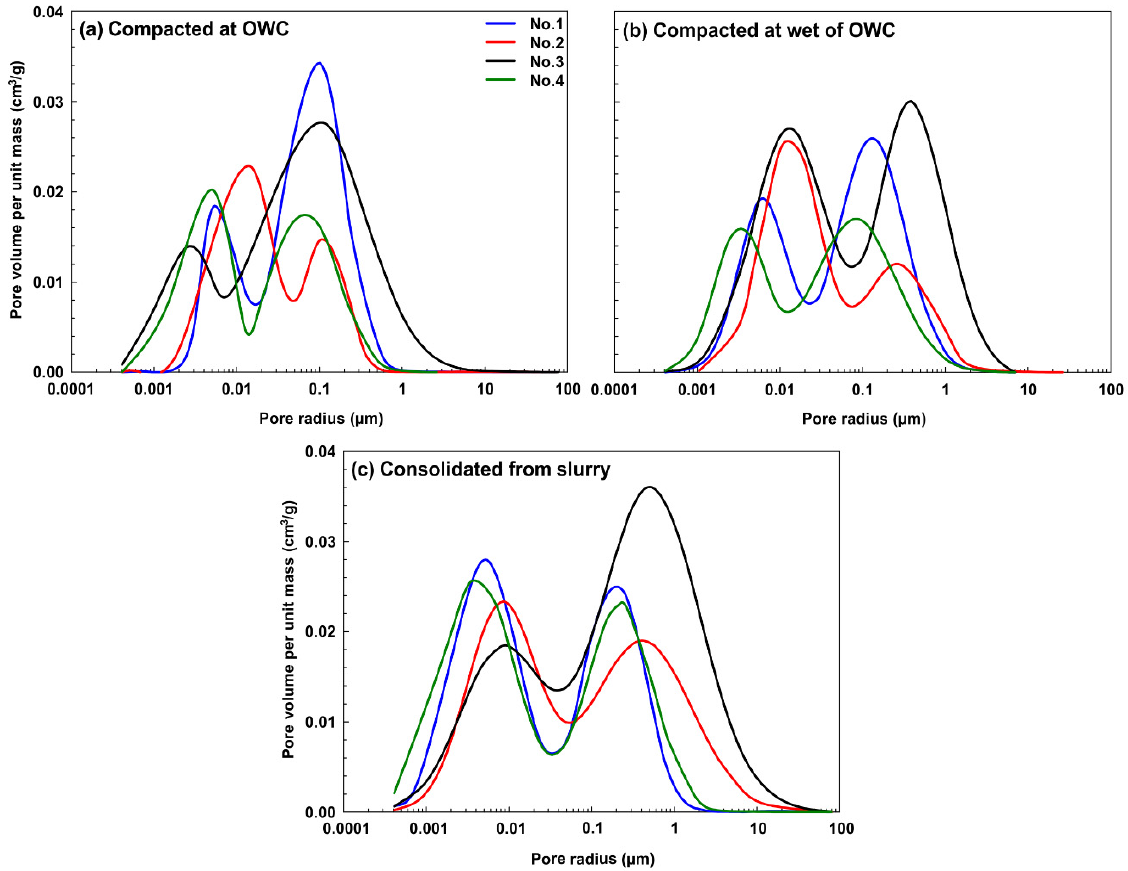
Figure 14. PSDs of clayey samples: ( a ) compacted at OWC, ( b ) compacted at wet of OWC, and ( c ) consolidated from slurry.